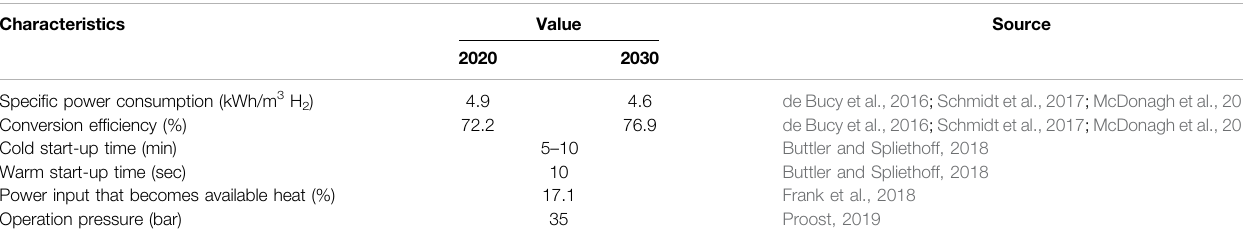
TABLE 1 | Speci fi cations of the proton-exchange membrane (PEM) electrolyser.